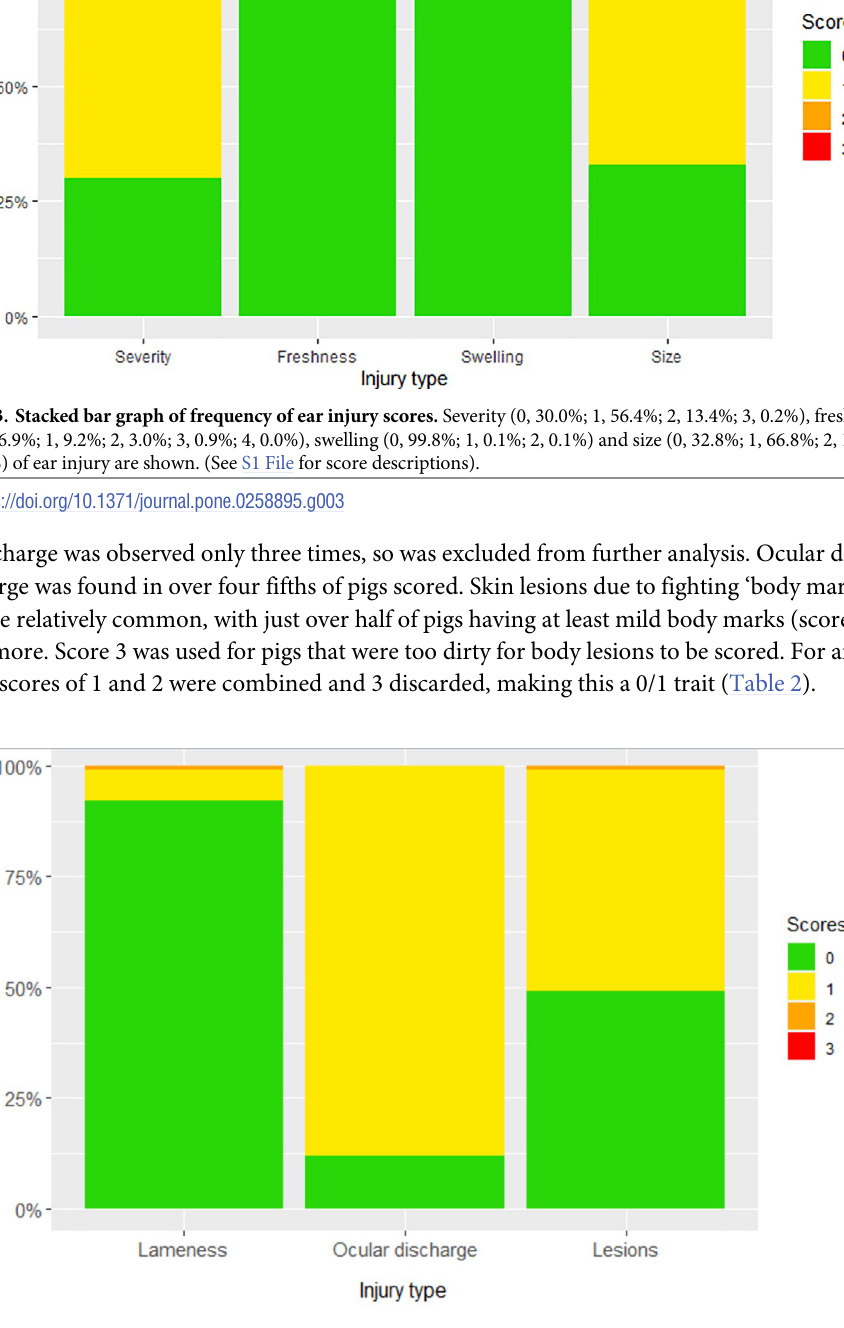
Fig 4. Stacked bar graph of frequency of other health scores. Lameness (0, 91.9%; 1, 7.0%; 2, 1.1%), Nasal discharge (0, 99.9%; 1, 0.1%), Ocular discharge (0, 12.3%; 1, 87.7%) and skin lesions resulting from social aggression (0, 49.1%; 1, 49.6%; 2, 0.9%; 3, 0.4%) (See S1 File for score